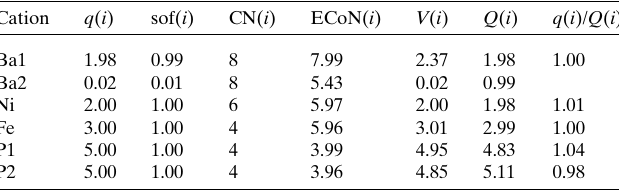
Table 1 Bond valence and CHARDI analyses for the cations in the title